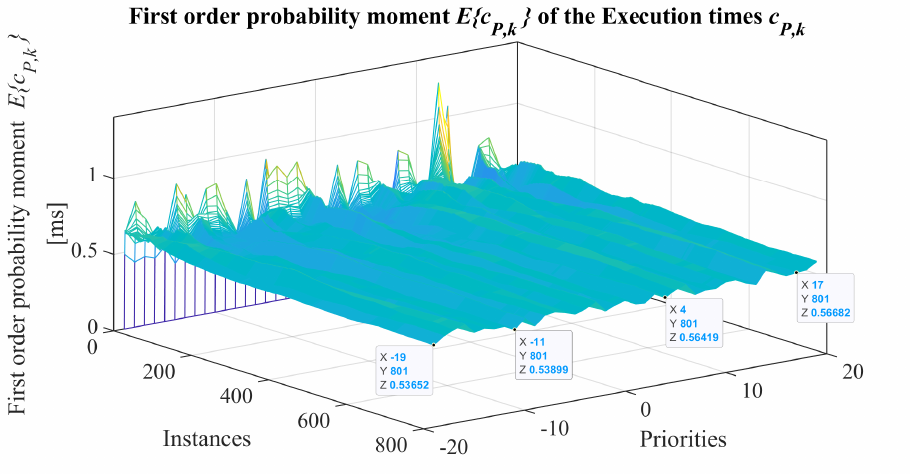
Figure 12. First probability moment of the real-time task’s execution times programmed using different